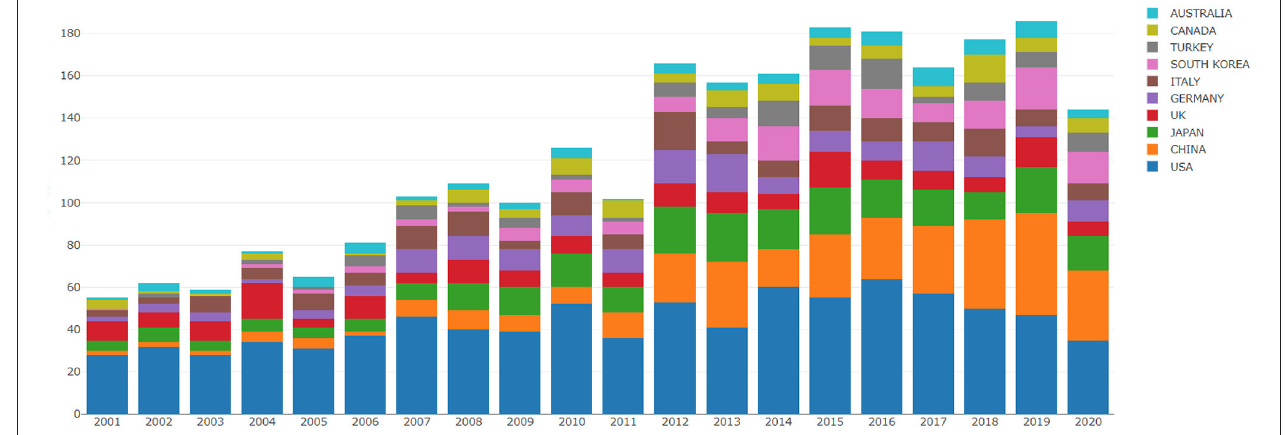
FIGURE 1 | The number of annual publications and growth trends of top 10 countries/regions on Endoscopic Sedation research from 2001 to